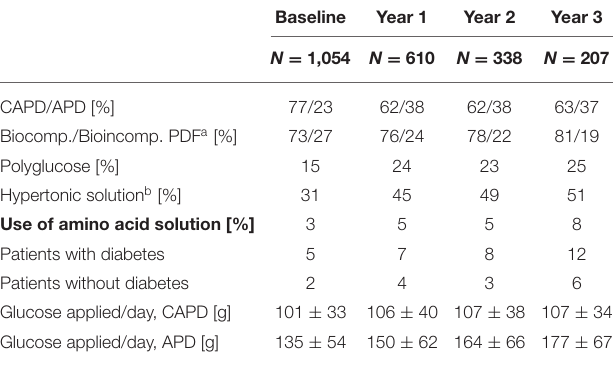
TABLE 2 | Peritoneal dialysis (PD)